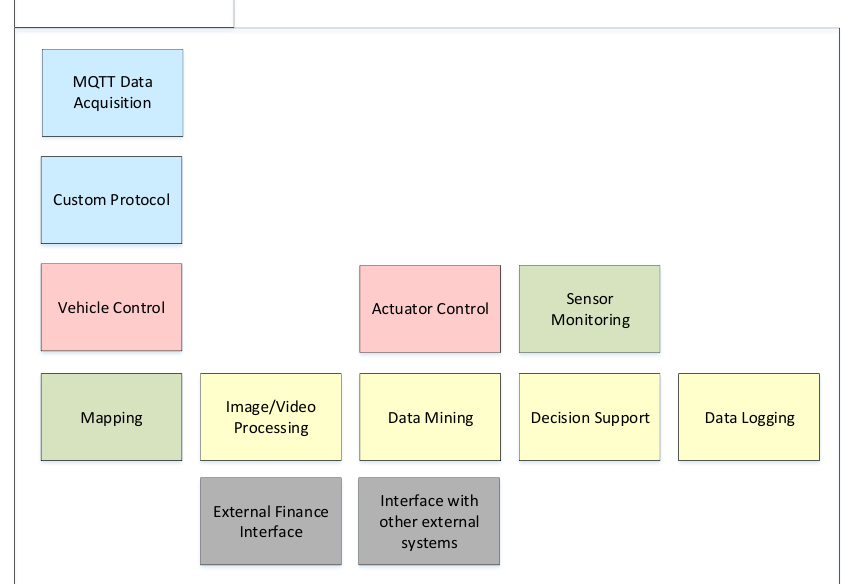
Figure 8. Decomposition View for Smart Charging System .